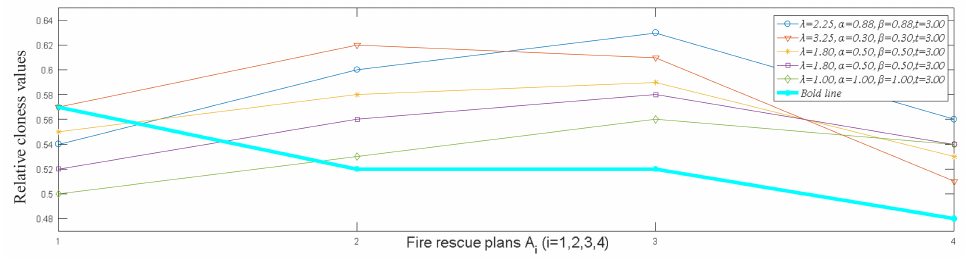
Figure 5. The diversity of the decision results obtained by different methods. Note. The bold line denotes the decision result obtained by the HFL-TOPSIS method